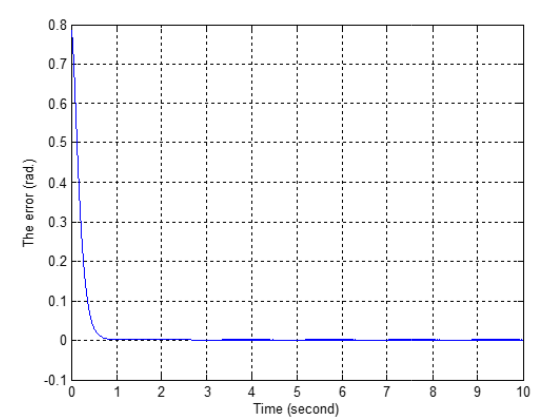
Fig. 20. The plot of sliding variable S vs. time of the The plot of sliding variable S vs. time of the ISMC .